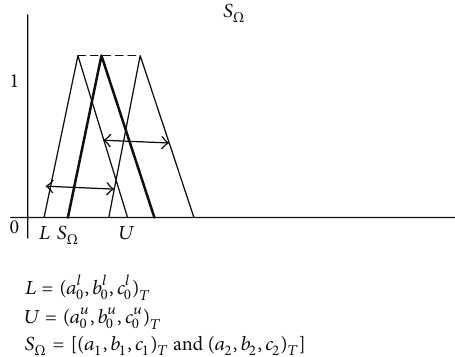
Figure 2: Graphical representation of confidence interval for 𝐻 0 (graph for 𝑆 Ω